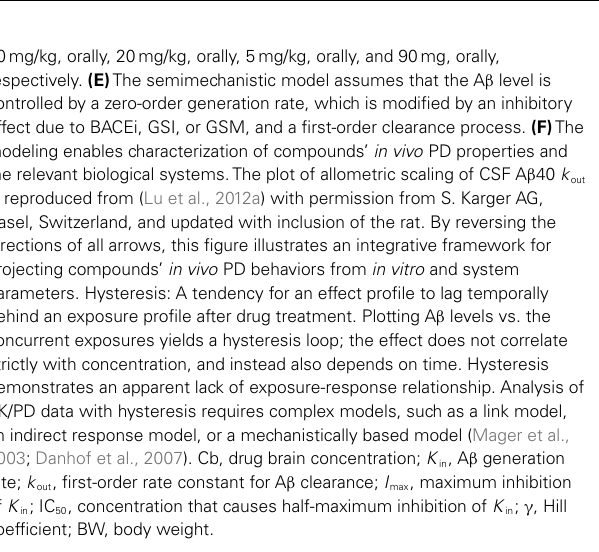
FIGURE 1 | Inherent complexities in PK/A β data (A–D), the semimechanistically based PK/PD model (E) for analyzingA β data,